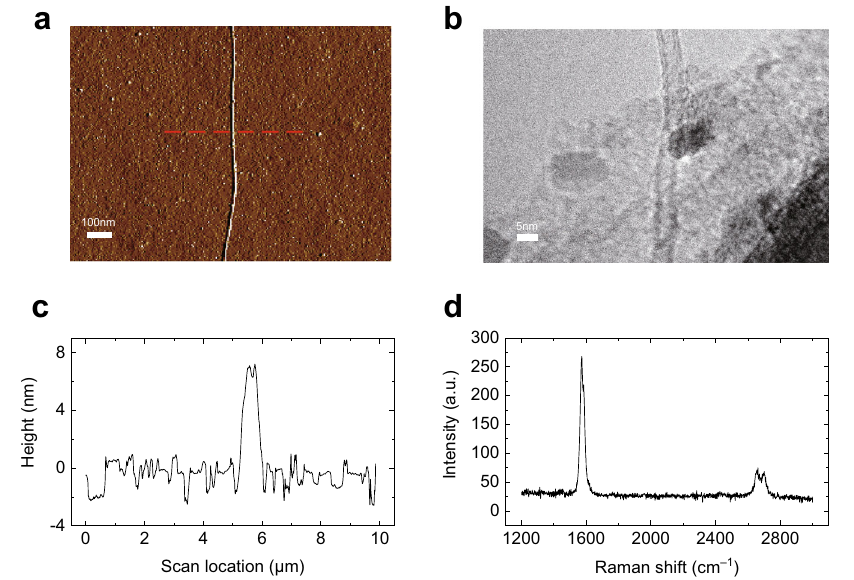
Fig. 2 | Characterization of individual carbon nanotube. a AFM scan image of a singleCNT.Scale bar: 100nm. b TEM image shows thatthe singleCNTisa double- walledtubewithanouterdiameterof5.3nmandaninnerdiameterof4.6nm.Scale bar: 5nm. c The cross-section corresponding to the position of the dashed line in